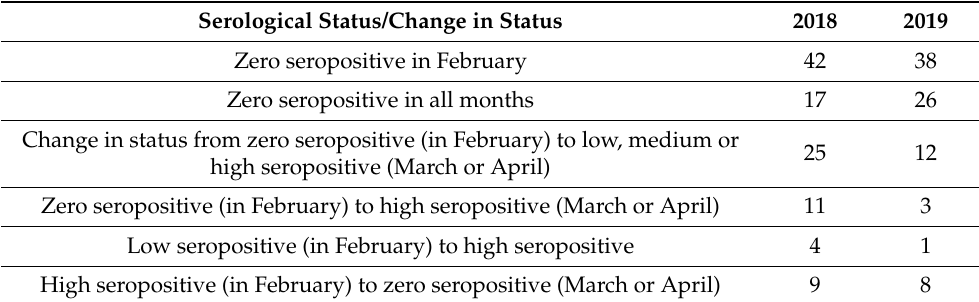
Table 3. Serological status of 70 sentinel duck flocks, 2018 and 2019.